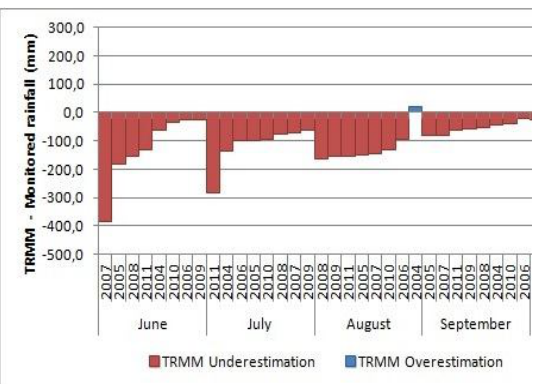
Figure 15. Overestimation and underestimation from June to September